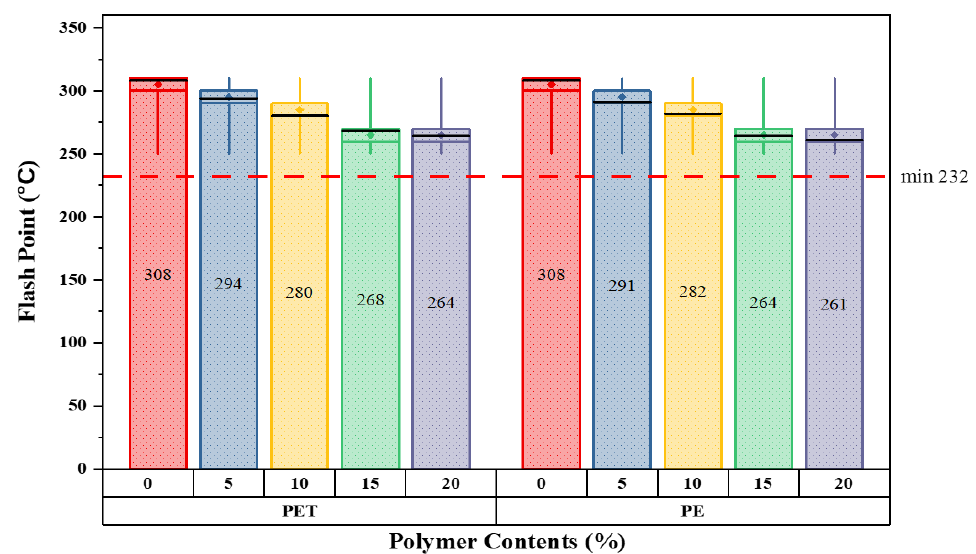
Figure 7. Flashpoint values with varying plastic content percentages.